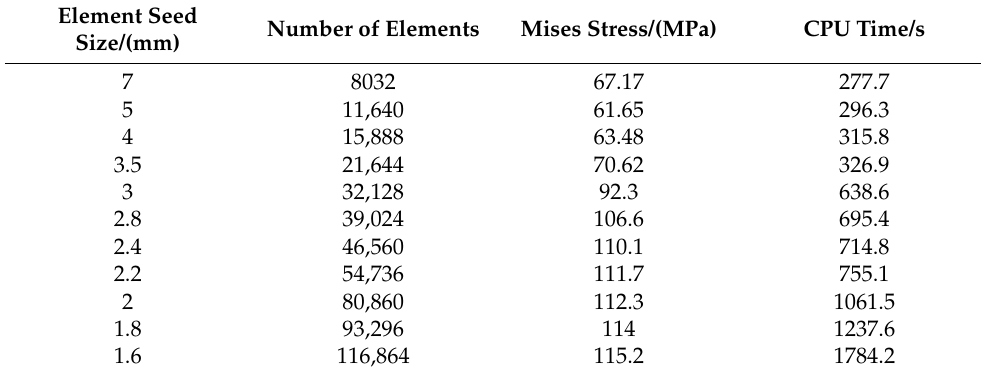
Table 1. Mises stress and computational cost with different numbers of elements of the hierarchical stiffened plate.